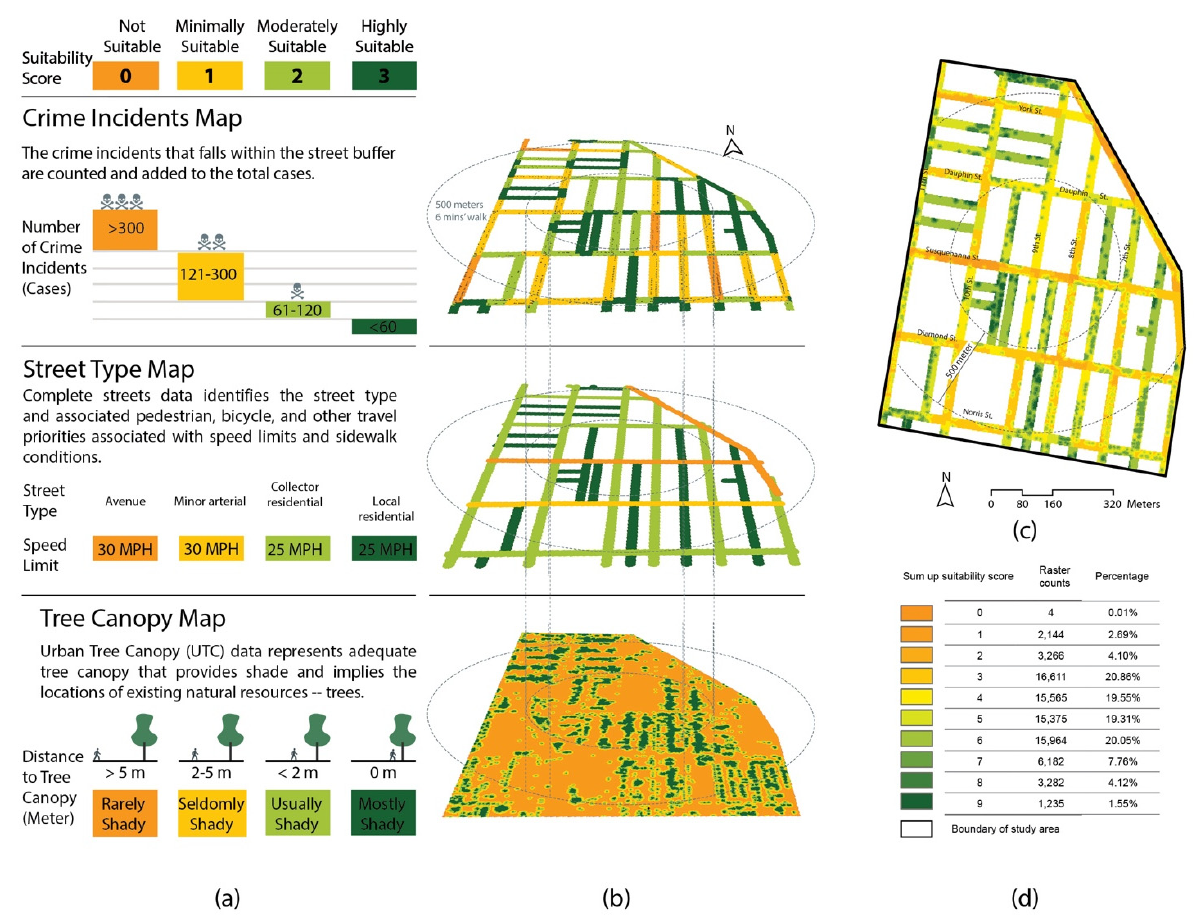
Figure 3. ( a ) Suitability Matrices for Streets; ( b ) Individual Street Suitability maps; ( c ) Aggregated Street Suitability map; ( d ) Street Suitability Score summary